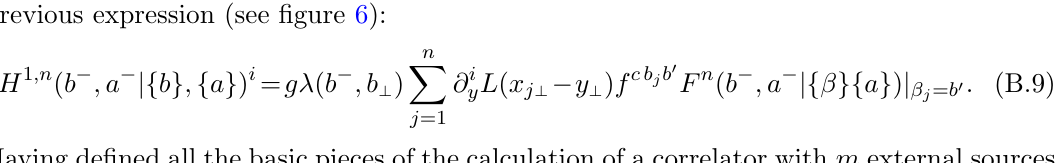
) f cb j b 0 @ y L ( x j y ) factor. ? ? (cid:0) ?